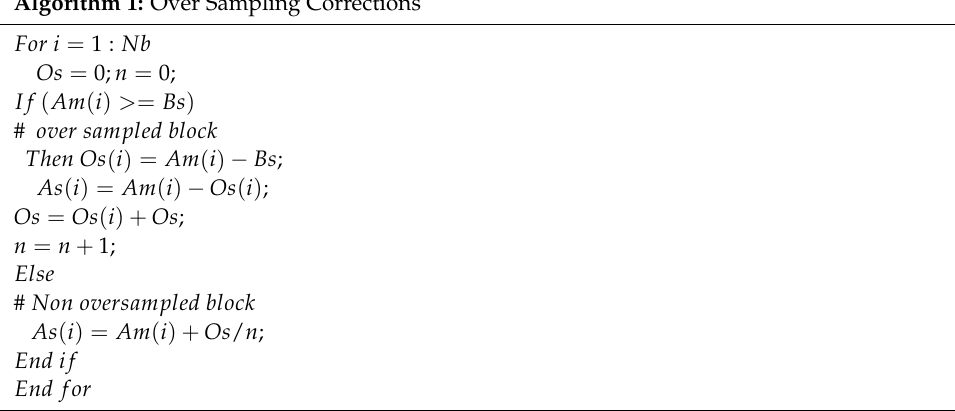
Algorithm 1: Over Sampling